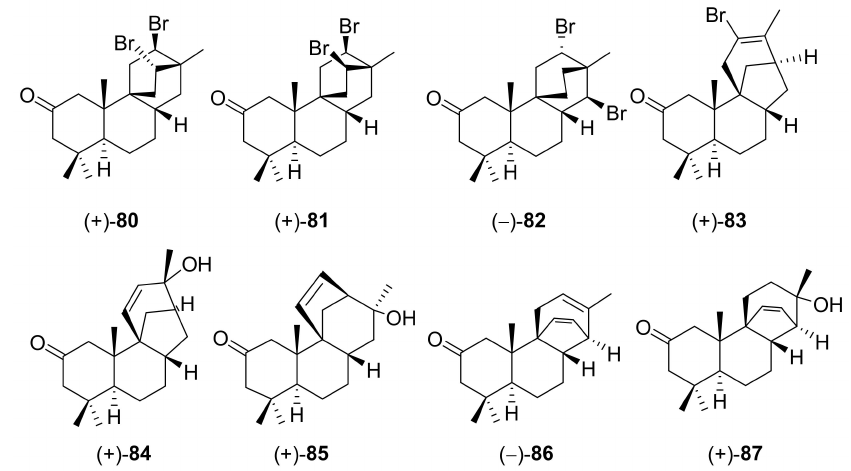
Figure 16. (+)-Stemodin ( 1 ) analogues and derivatives tested.